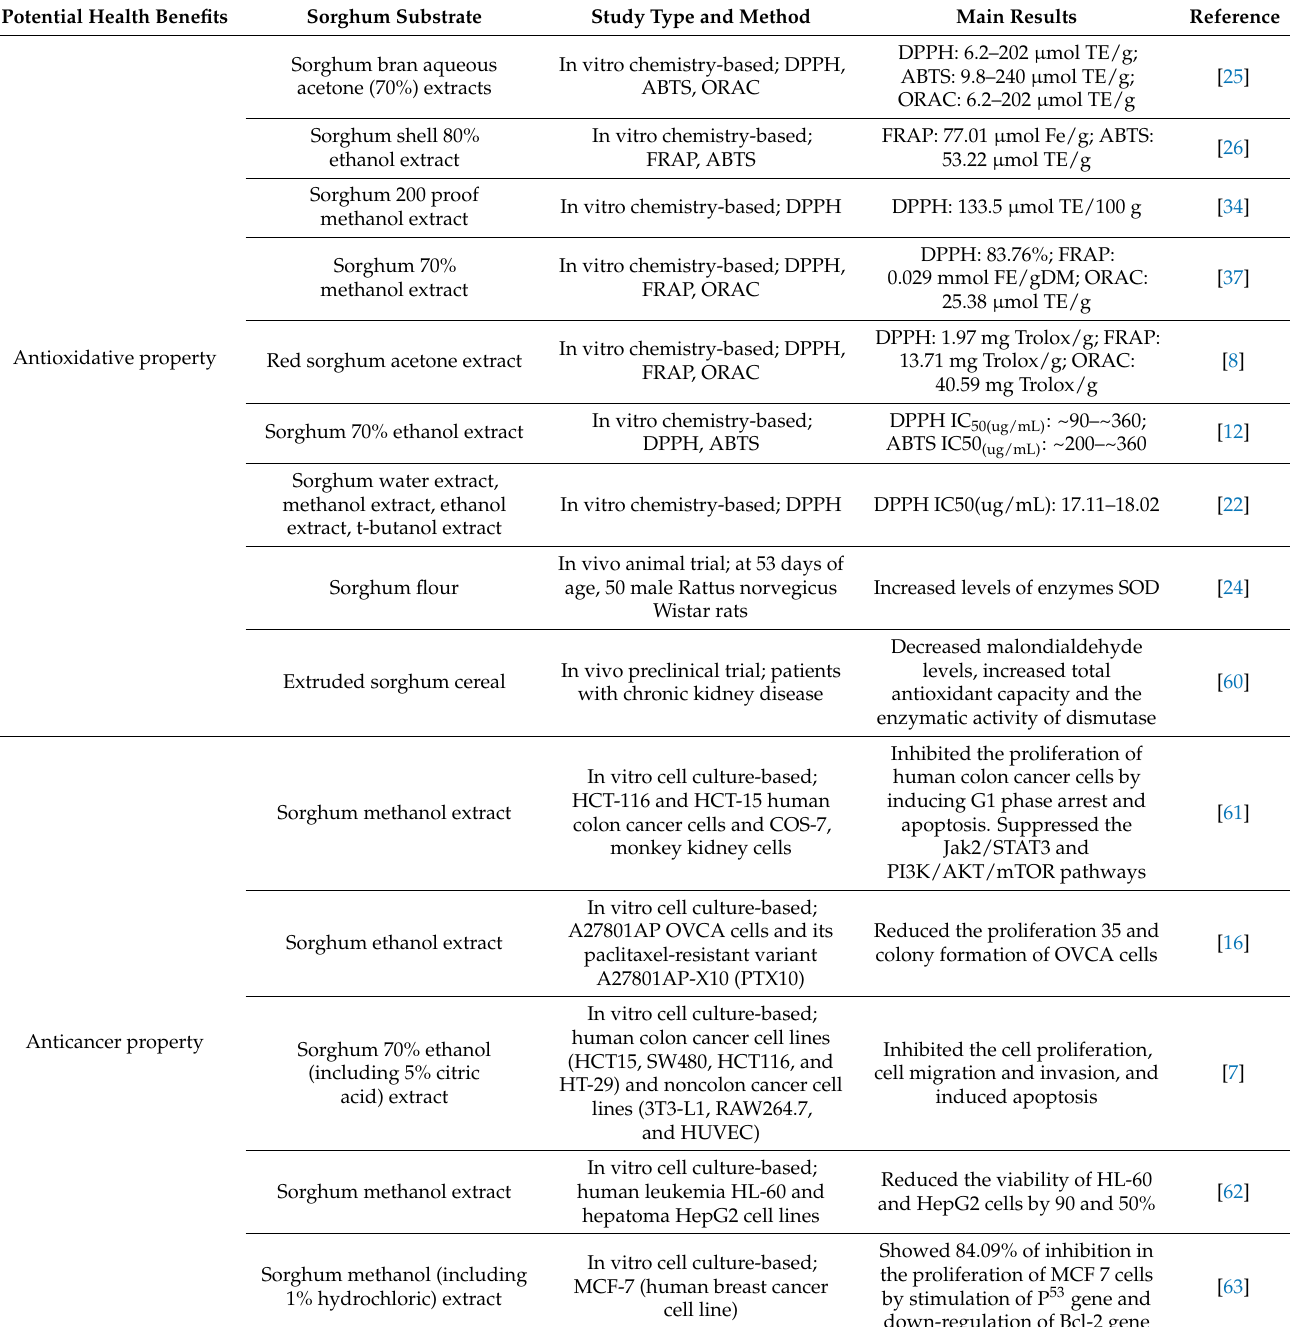
Table 4. Potential health benefits of sorghum